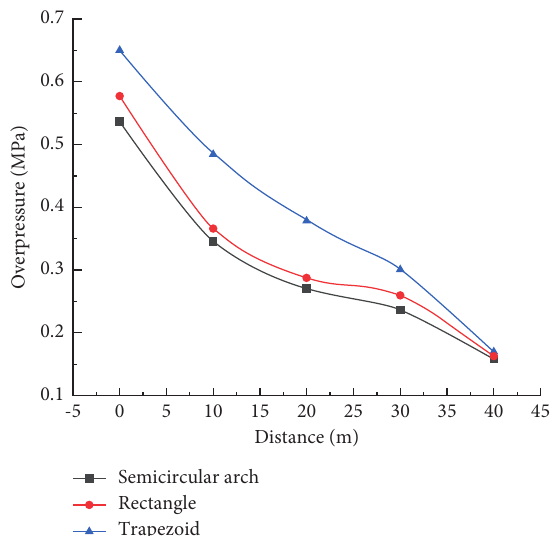
Figure 13: Pressure change of return air tunnel with different cross-sectional shapes.